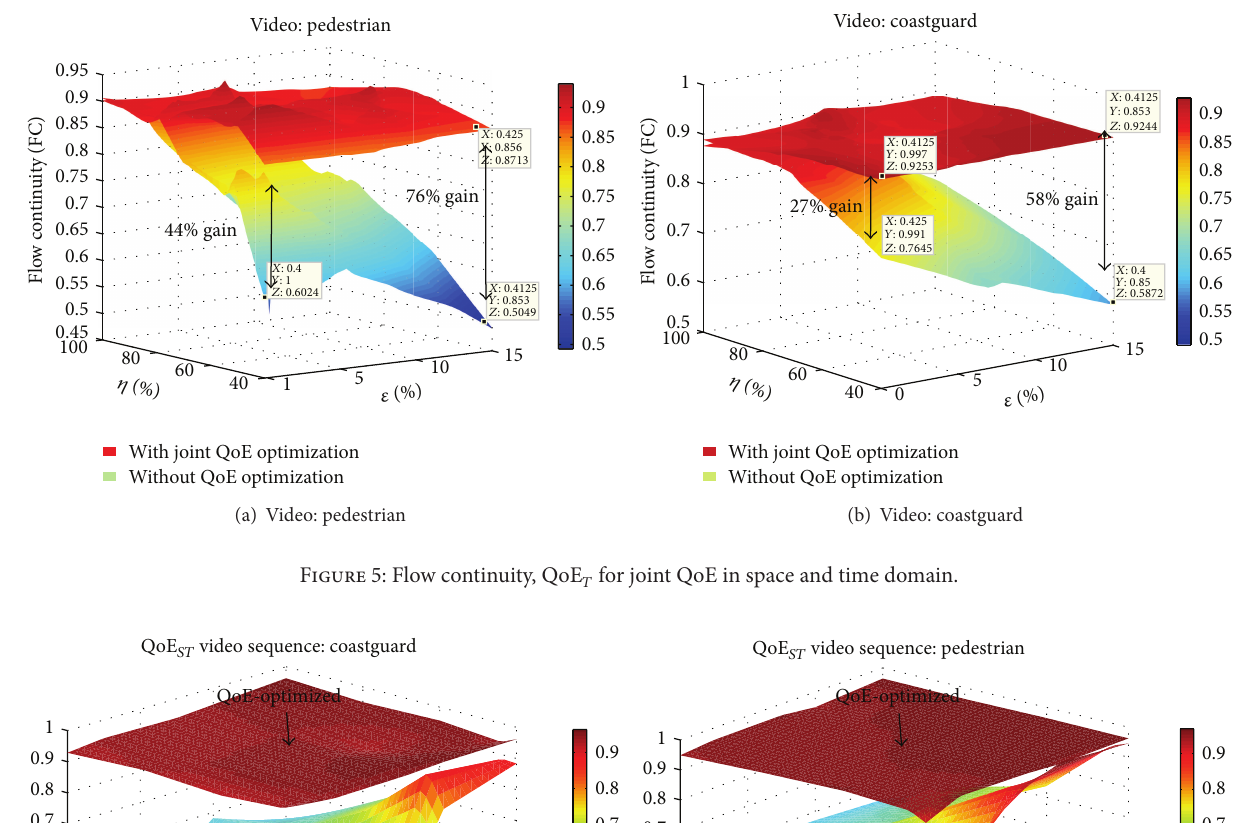
Figure 5: Flow continuity, QoE 𝑇 for joint QoE in space and time domain.